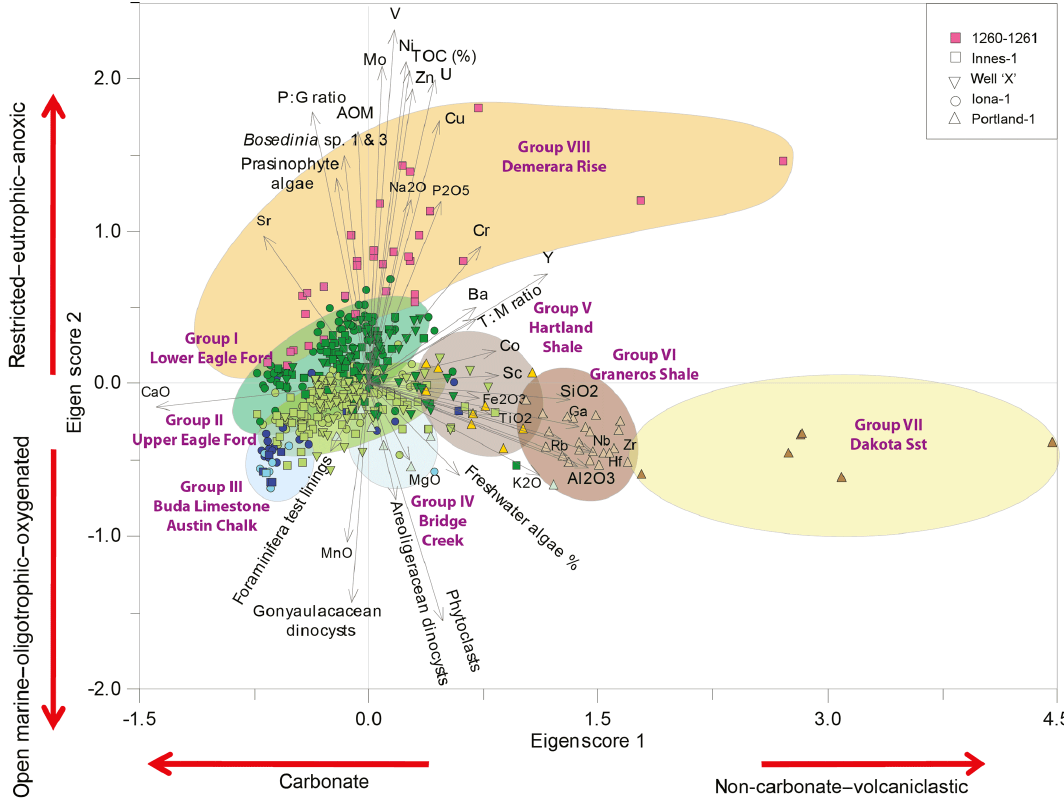
Figure 12. PCA results showing principle axis/eigenscores; selected environmental variables. Samples plotted as a function of site location (see insert) and lithostratigraphic interval (colours; groups in